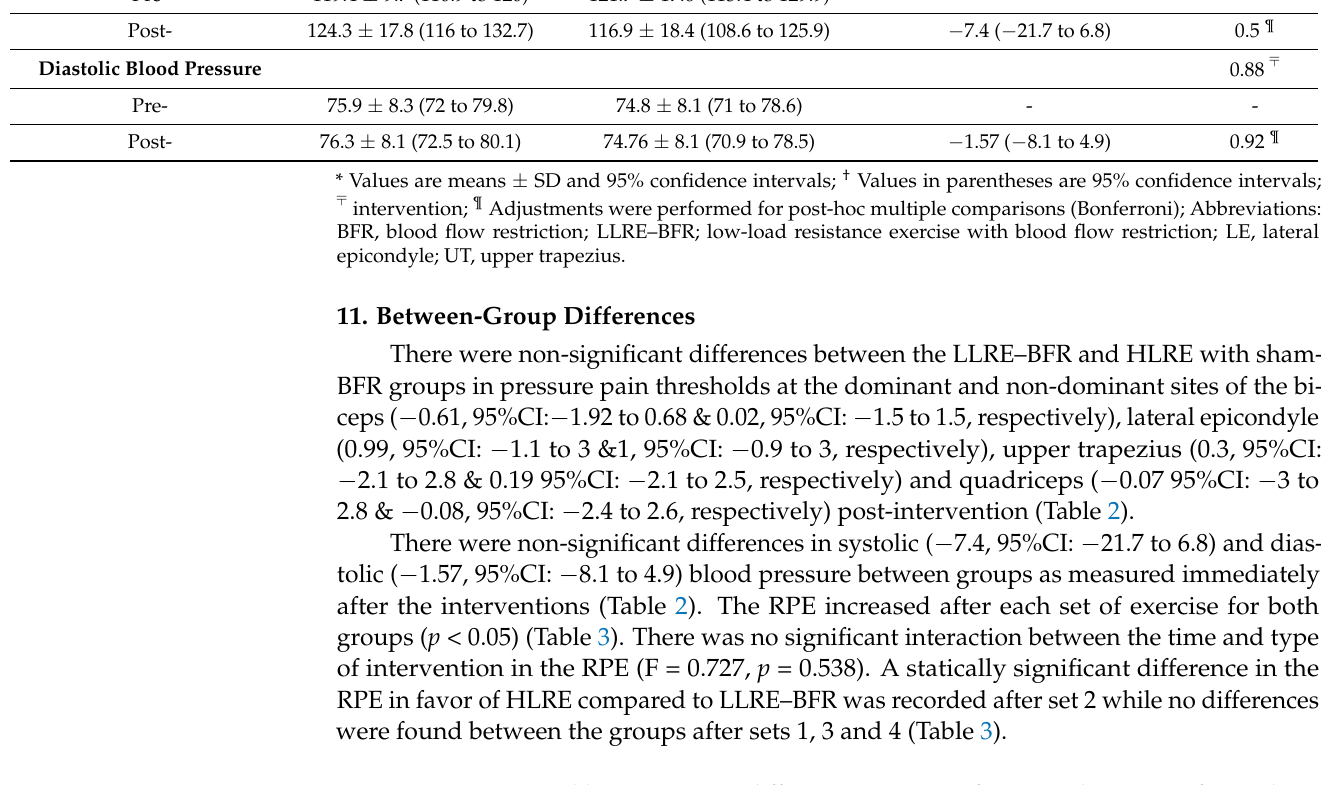
Table 3. Outcomes and between-group differences in rating of perceived exertion after each set of